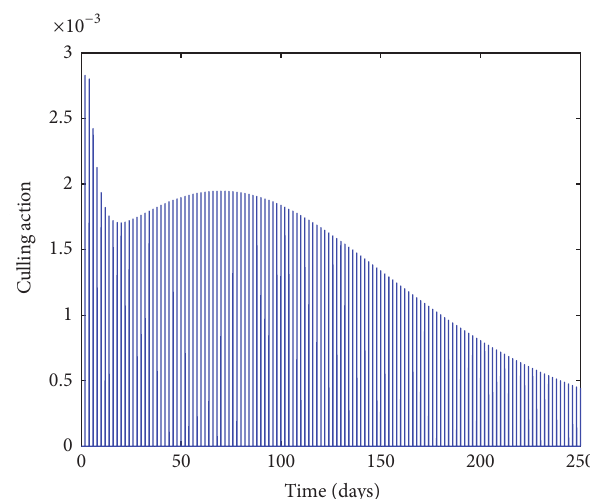
Figure 11: Culling effort 𝜌 𝐷 𝐷(𝑡) with an every other culling rate of = 0.8 . 𝜌 𝐷